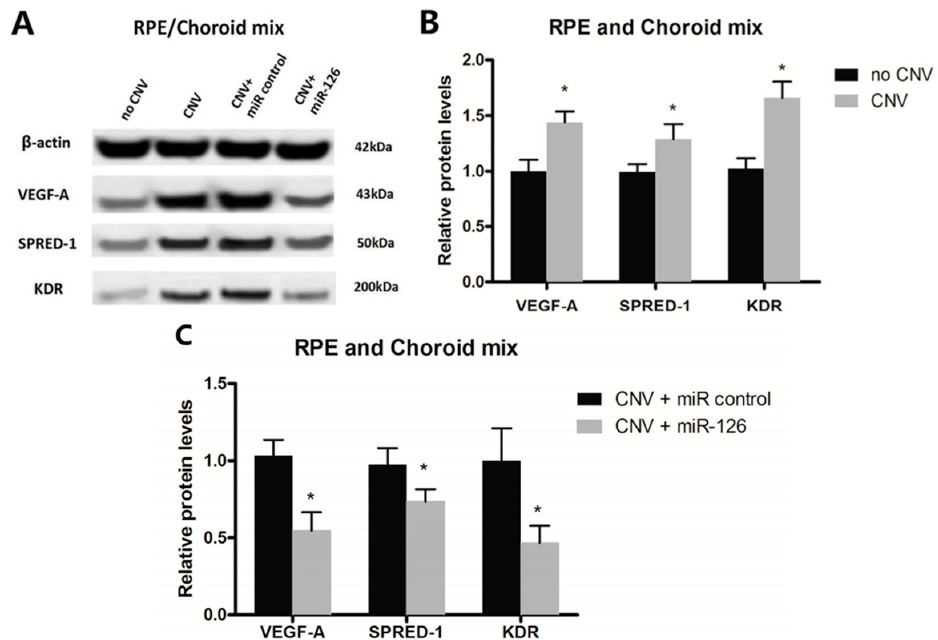
Figure 3. Changes of miR-126 target genes protein level in the eyes of CNV mice: ( A ) Western blot expression pattern of VEGF-A , KDR and SPRED-1 in different groups of mice with or without CNV, and CNV mice transfected with miR-control or miR-126 ; ( B ) quantification of relative target genes protein expression in no CNV and CNV groups; and ( C ) relative expression of target genes protein in a different group of CNV mice after transfection. Data are expressed as relative fold change of protein level ± SD, n = 12, * p < 0.05.